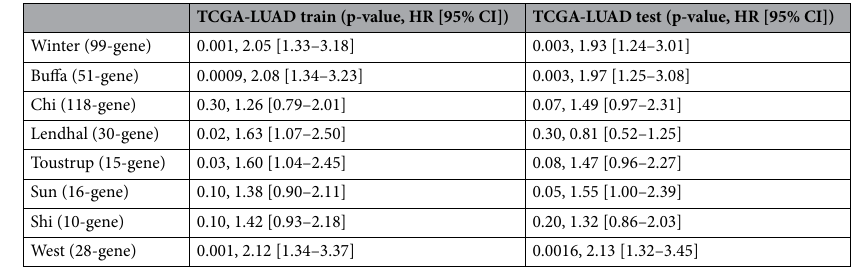
Table 3. Comparison of gene signatures in TCGA-LUAD train and test